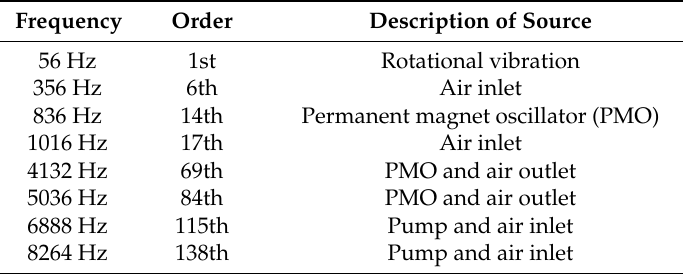
Table 1. Description of sources for the small air